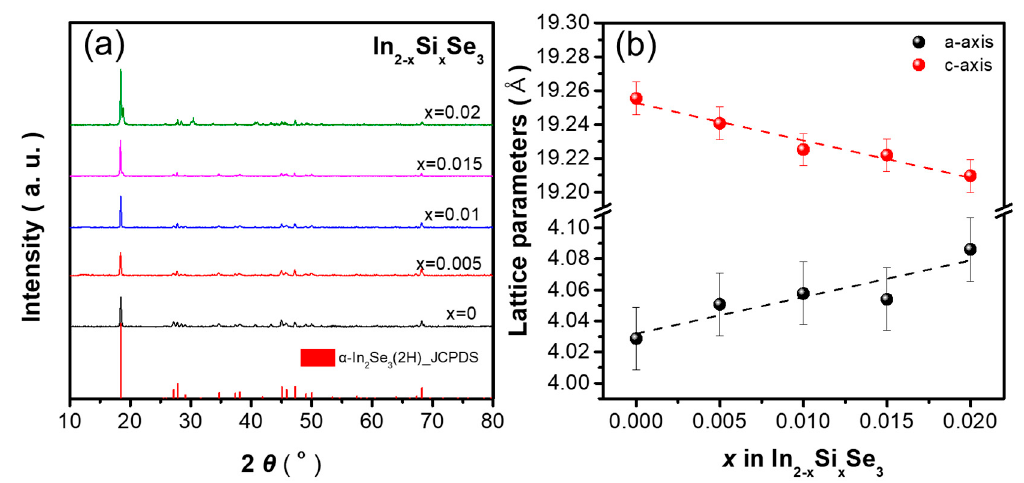
Figure 1. ( a ) X ‐ ray diffraction patterns and ( b ) calculated lattice parameters for the In 2 − x Si x Se 3 ( x = 0, 0.005, 0.01, 0.015, and 0.02) samples.